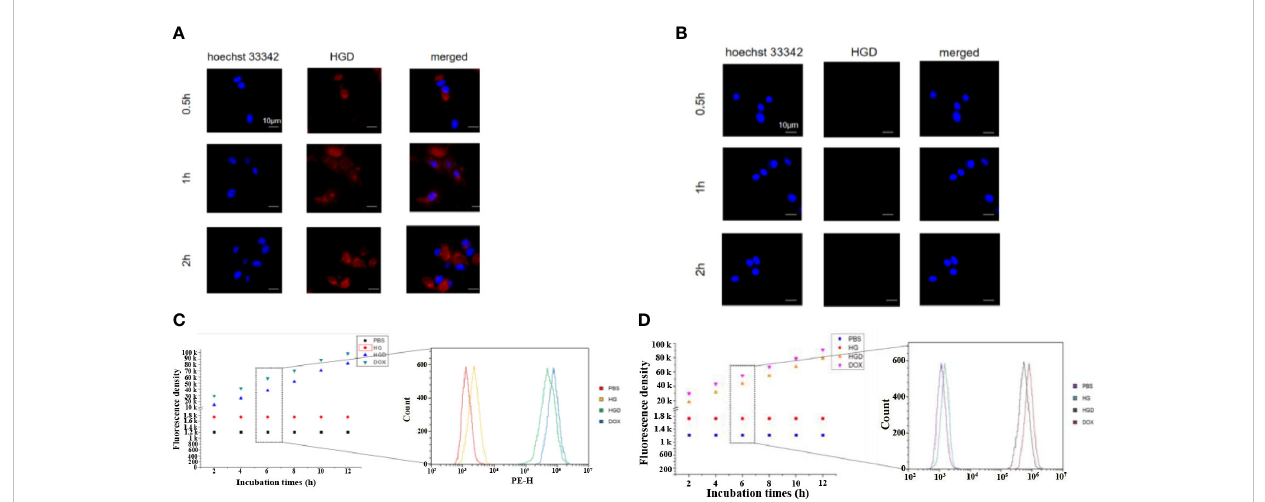
FIGURE 3 CLSM images after feeding free DOX and HBc-GE11-DOX to MDA-MB-231 (A) and MDA-MB-453 cells (B) at different time intervals. Red, DOX; blue, DAPI for cell nucleus. The scale bar is 10 m m. (C, D) Flow cytometry of MCF7 (C) and MDA-MB-231 cells (D) by the cellular uptake assay after feeding HBc VLPs, HBc-GE11-DOX, or free DOX for different